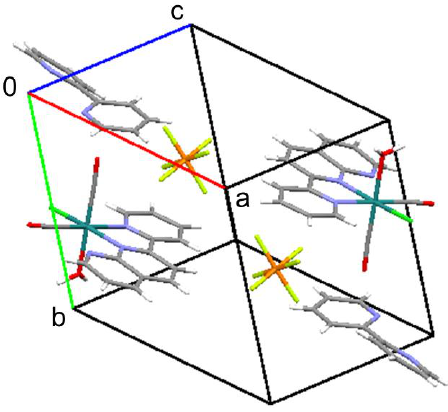
Figure 4. Packing diagram of the title compound.